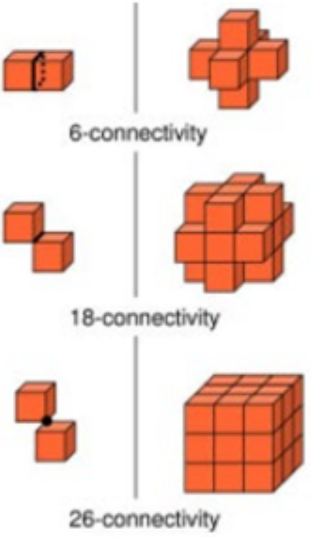
Figure 3. voxel connectivity, 6 neighbourhood, 18 neighbourhood and a 26 neighbourhood